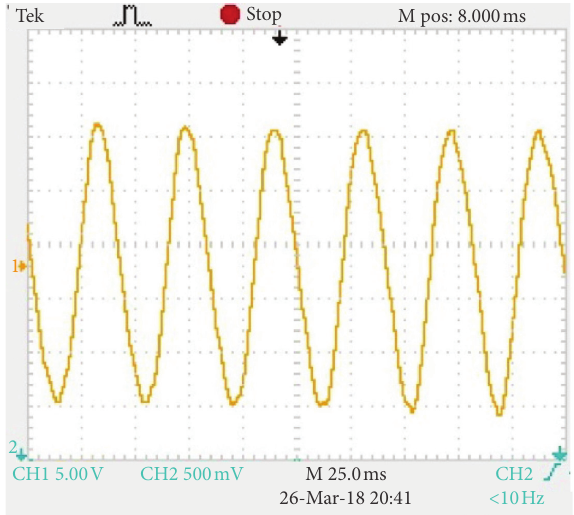
Figure 12: Phase current experimental waveform of